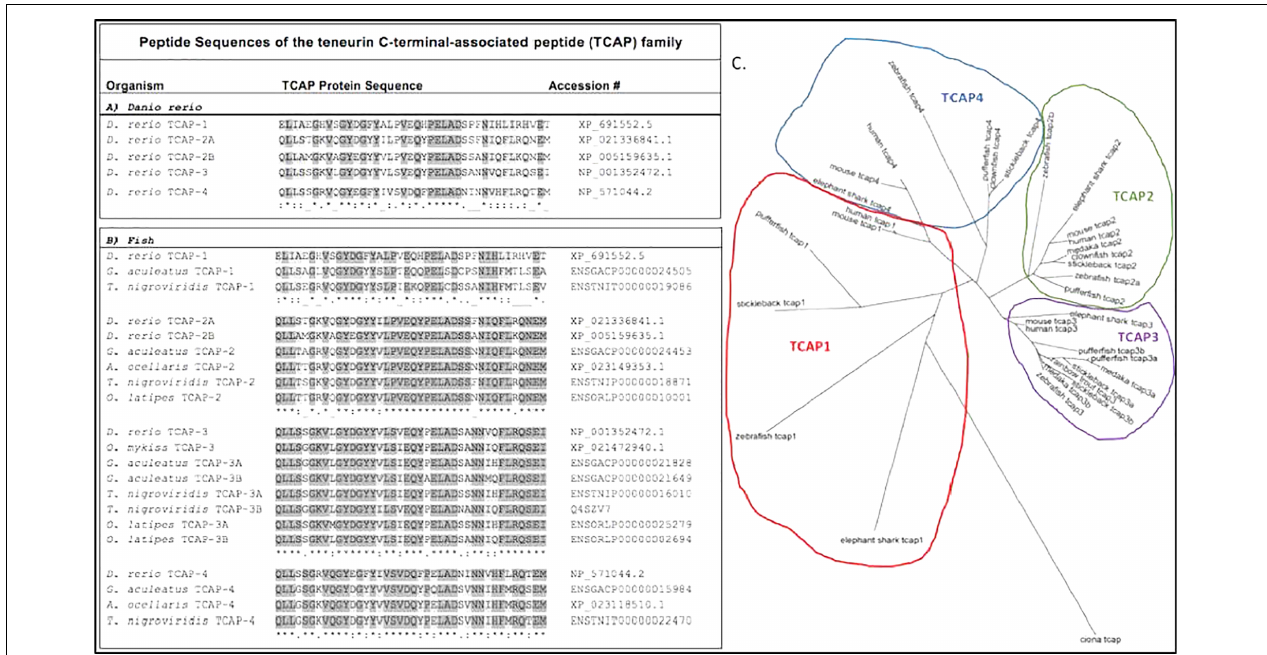
FIGURE 2 | Predicted peptide sequences of the TCAP family from fishes. Sequences predicted from predicted full length teneurin proteins on Ensemble. (A) Clustal Omega alignment of TCAP paralogs from the zebrafish ( Danio rerio ). (B) Alignment of TCAP orthologs from selected teleost species: zebrafish, D. rerio ; stickleback, Gasterosteus aculeatus ; spotted pufferfish, Tetraodon nigroviridis ; clownfish, Amphiprion ocellaris ; medaka, Oryzias latipes ; rainbow trout, Oncorhynchus mykiss . (C) Predicted TCAP peptide sequences used to generate a Clustal Omega alignment and build this unrooted phylogenetic tree to predict evolutionary relationship of fish TCAP